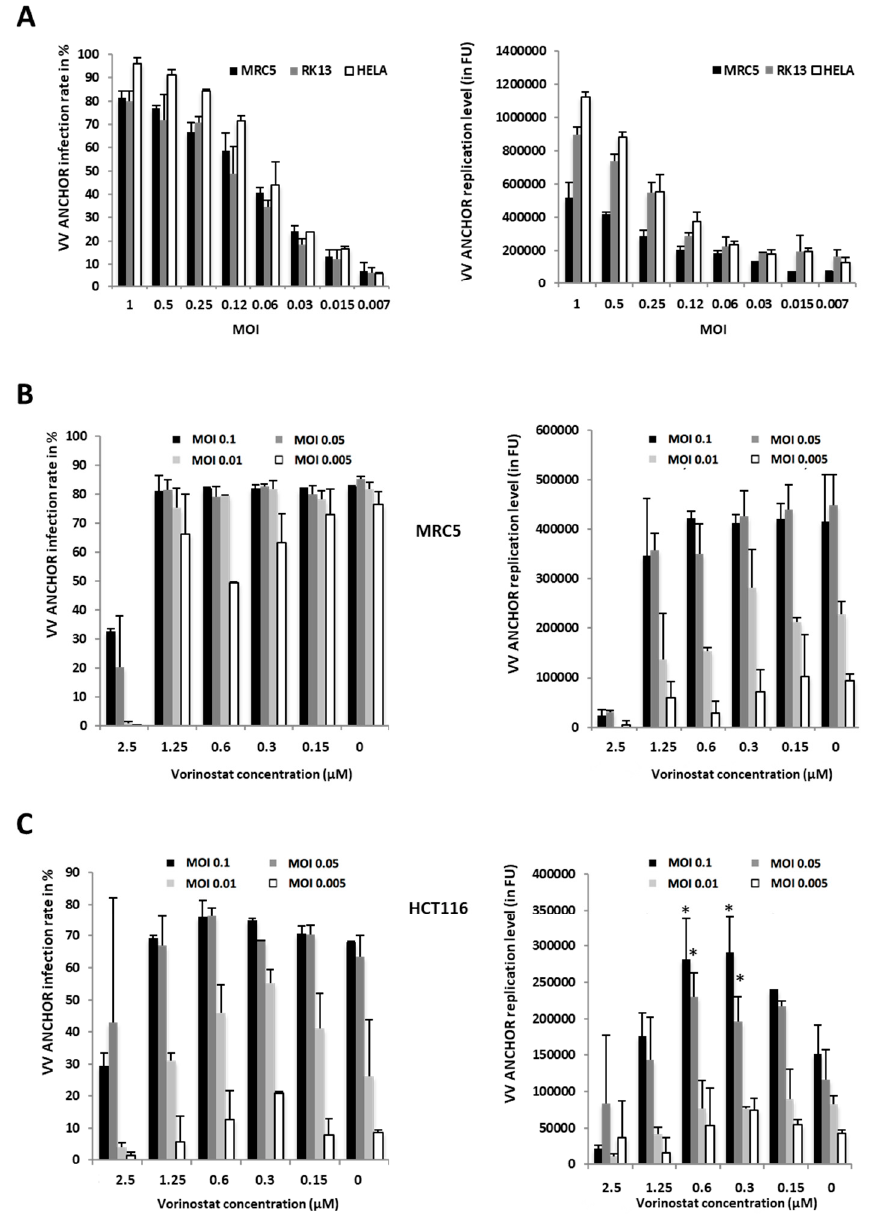
Figure 4. Use of VACV ANCHOR to measure infection capacities and the impact of oncolytic activators. ( A ) Cell lines were plated in 96 well plates and infected with VACV ANCHOR at the indicated MOI. Twenty-four hours post-infection, cells were fixed and stained with Hoechst 33342. Quantification of the infection rate and the VACV ANCHOR replication level was performed on a Cellomics Arrayscan high content microscope. Results are the average of 3 independent wells + SD. ( B ) MRC-5 cells were treated with increasing concentrations of vorinostat and immediately infected with VACV ANCHOR at the corresponding MOI. Cells were fixed and processed for high-content imaging (HCI) as in A, 48 h post-infection. Results are the average of 3 independent wells ± SD. ( C ) HCT 116 cells were treated with increasing concentrations of vorinostat and immediately infected with the corresponding MOI. Cells were fixed and processed for HCI as in A, 48 h post-infection. Results are the average of 3 independent wells ± SD. * p < 0.05 compared to cells infected at the same MOI without vorinostat treatment.